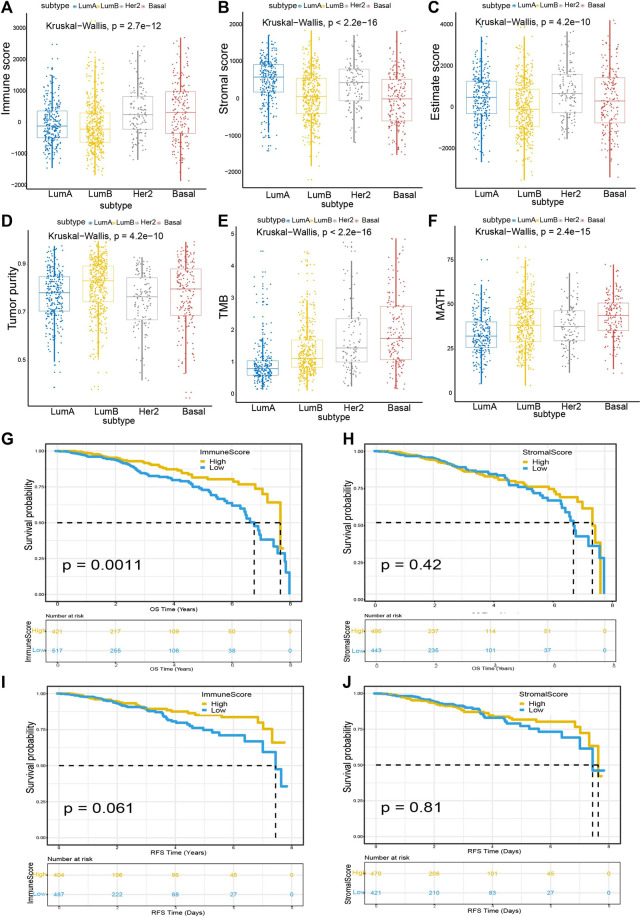
Tumor microenvironmental factors were tightly associated with breast cancer subtypes and Immune score (A) Box-plot shows a significant association between breast cancer subtypes and the level of Immune score (n = 1,040, p = 2.7e − 12) (B) Box-plot reveals the significant association between breast cancer subtypes and the level of Stromal score (n = 1,040, p < 2.2e − 16) (C–F) Box-plot shows a significant correlation between breast cancer subtype and Estimate score (n = 1,040, p = 4.2e − 10), Tumor purity (n = 1,040, p = 4.2e − 10), TMB (n = 1,040, p < 2.2e − 16), MATH (n = 1,040, p = 2.4e − 15) (G) Breast cancer cases were divided into two groups based on their average expression of Immune scores. A high Immune score predicts a favorable prognosis for overall survival (OS). As indicated by the log-rank test, p = 0.0011 (H) Similarly, breast cancer cases were parted into two groups based on their average expression of Stromal scores. The survival time for OS of the high Stromal score group is longer than that of the low Stromal score group, although the difference was not statistically significant (p = 0.42) (I) A similar grouping based on Immune scores was used for RFS (relapse-free survival) survival analysis (J) A similar grouping based on Stromal scores was used for RFS survival analysis.